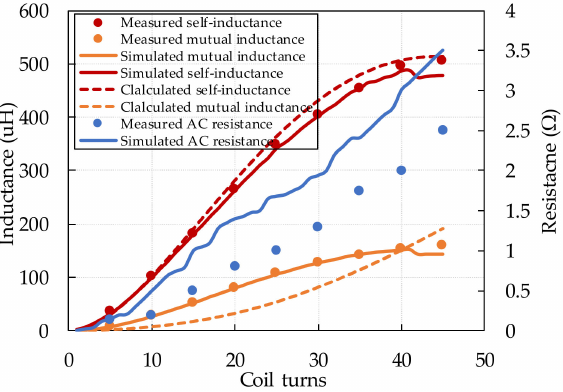
Figure 10. Relationship between coil turns and coil-system parameters with fixed outer